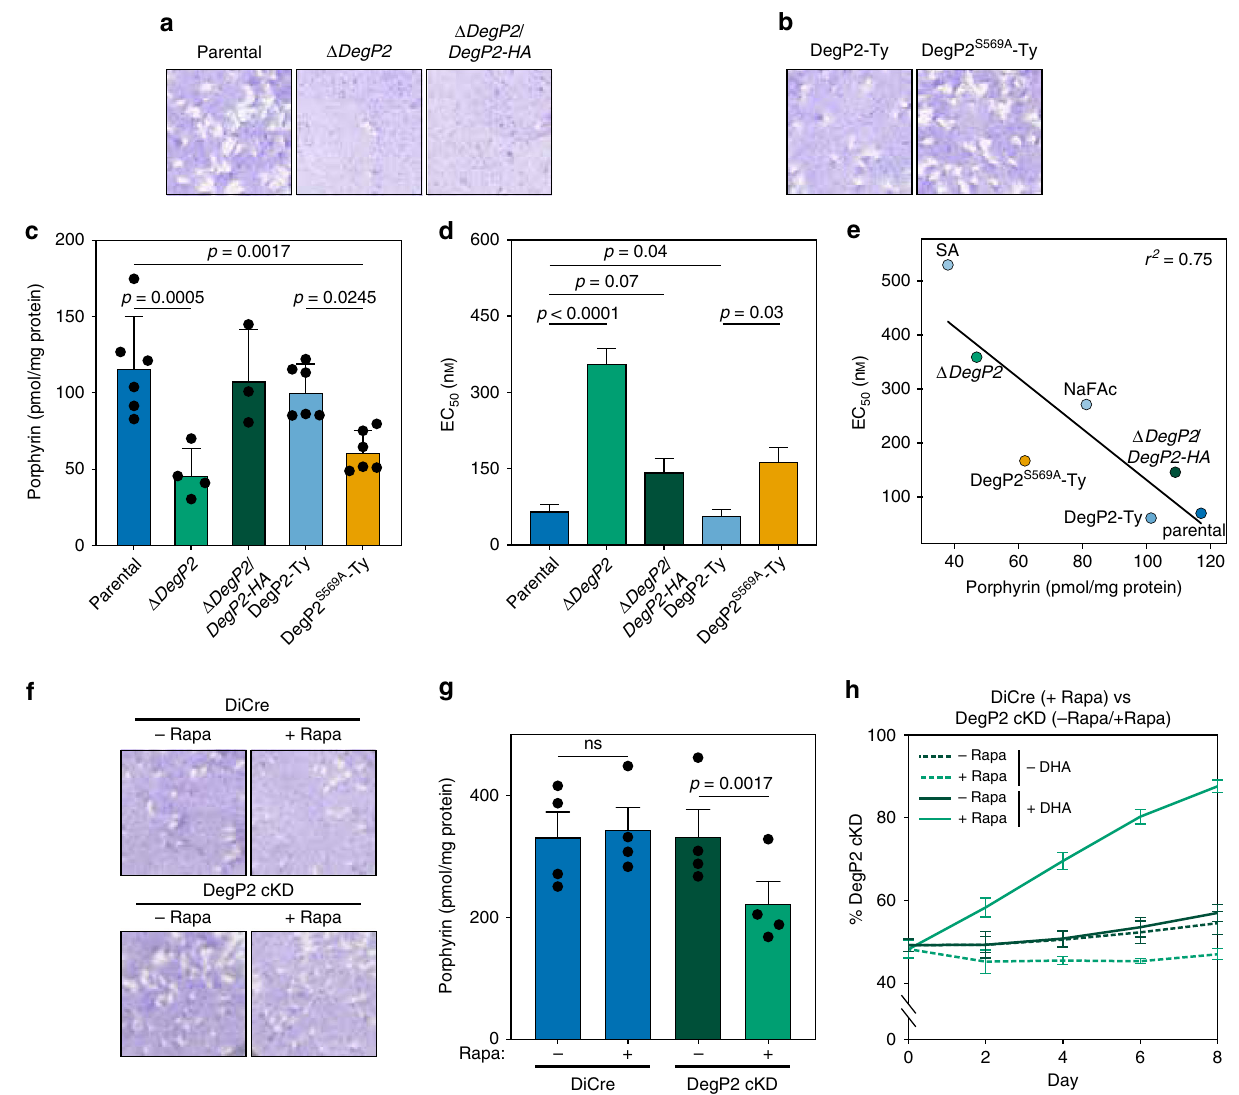
Fig. 5 Deletion of DegP2 alters porphyrin concentrations and DHA susceptibility. a Δ DegP2 and Δ DegP2 / DegP2-HA parasites formed smaller plaques than their parental strains, indicating a growth defect. b Endogenously Ty-tagged DegP2 (DegP2-Ty) parasites and a derived line bearing a mutation in the protease domain (DegP2 S569A -Ty) formed plaques normally. c Total porphyrin concentrations (pmol/mg protein) showing reduced porphyrin concentrations for both Δ DegP2 and DegP2 S569A -Ty parasites. Results are mean ± SD for n = 3 – 4 independent experiments; p -values are from one-way ANOVA with Sidak ’ s multiple comparison test. d DHA Mean EC 50 values± SD were calculated by curve- fi tting 4 – 7 independent experiments together. e Porphyrin levels show a negative correlation with DHA EC 50 ( r 2 = 0.75) in the strains and conditions tested. f DegP2 cKD parasites formed plaques similarly to DiCre, both in the presence or absence of rapamycin. g Total porphyrin concentrations for DiCre and DegP2 cKD in the presence or absence of rapamycin. Results are mean ± SEM for n = 4 independent experiments; p -values are from a two-way ANOVA. h DegP2 cKD parasites outcompeted DiCre parasites in the presence of DHA. The fraction of the population composed of mutant parasites was calculated at each time point by fl ow cytometry. Results are mean ± SEM for n = 3 independent